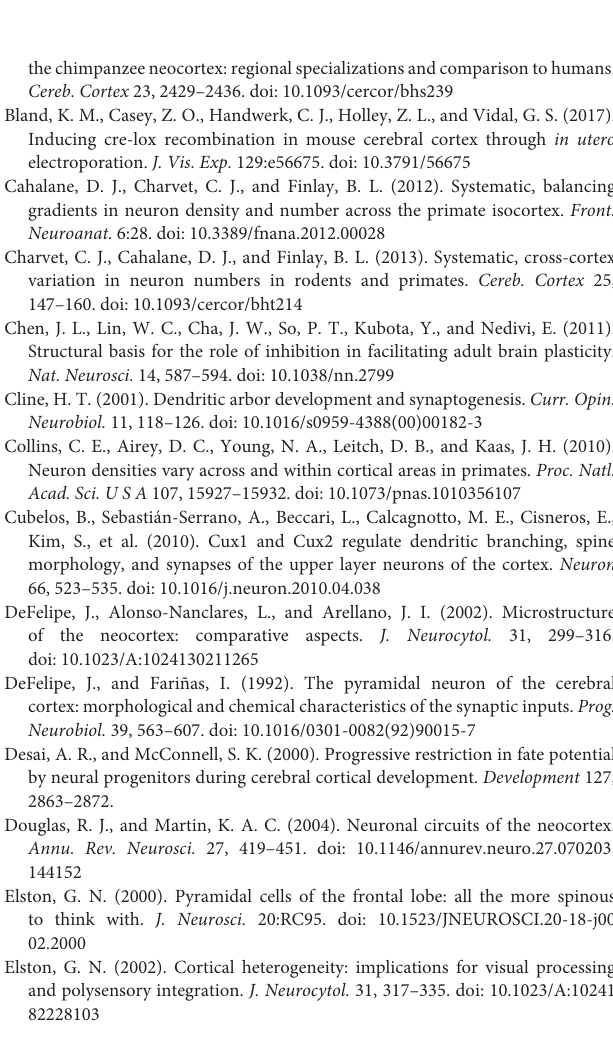
FIGURE S1 | Medium-magnification (20x) Z-stack of confocal images taken of cell #5 (see inset in Figure 1C